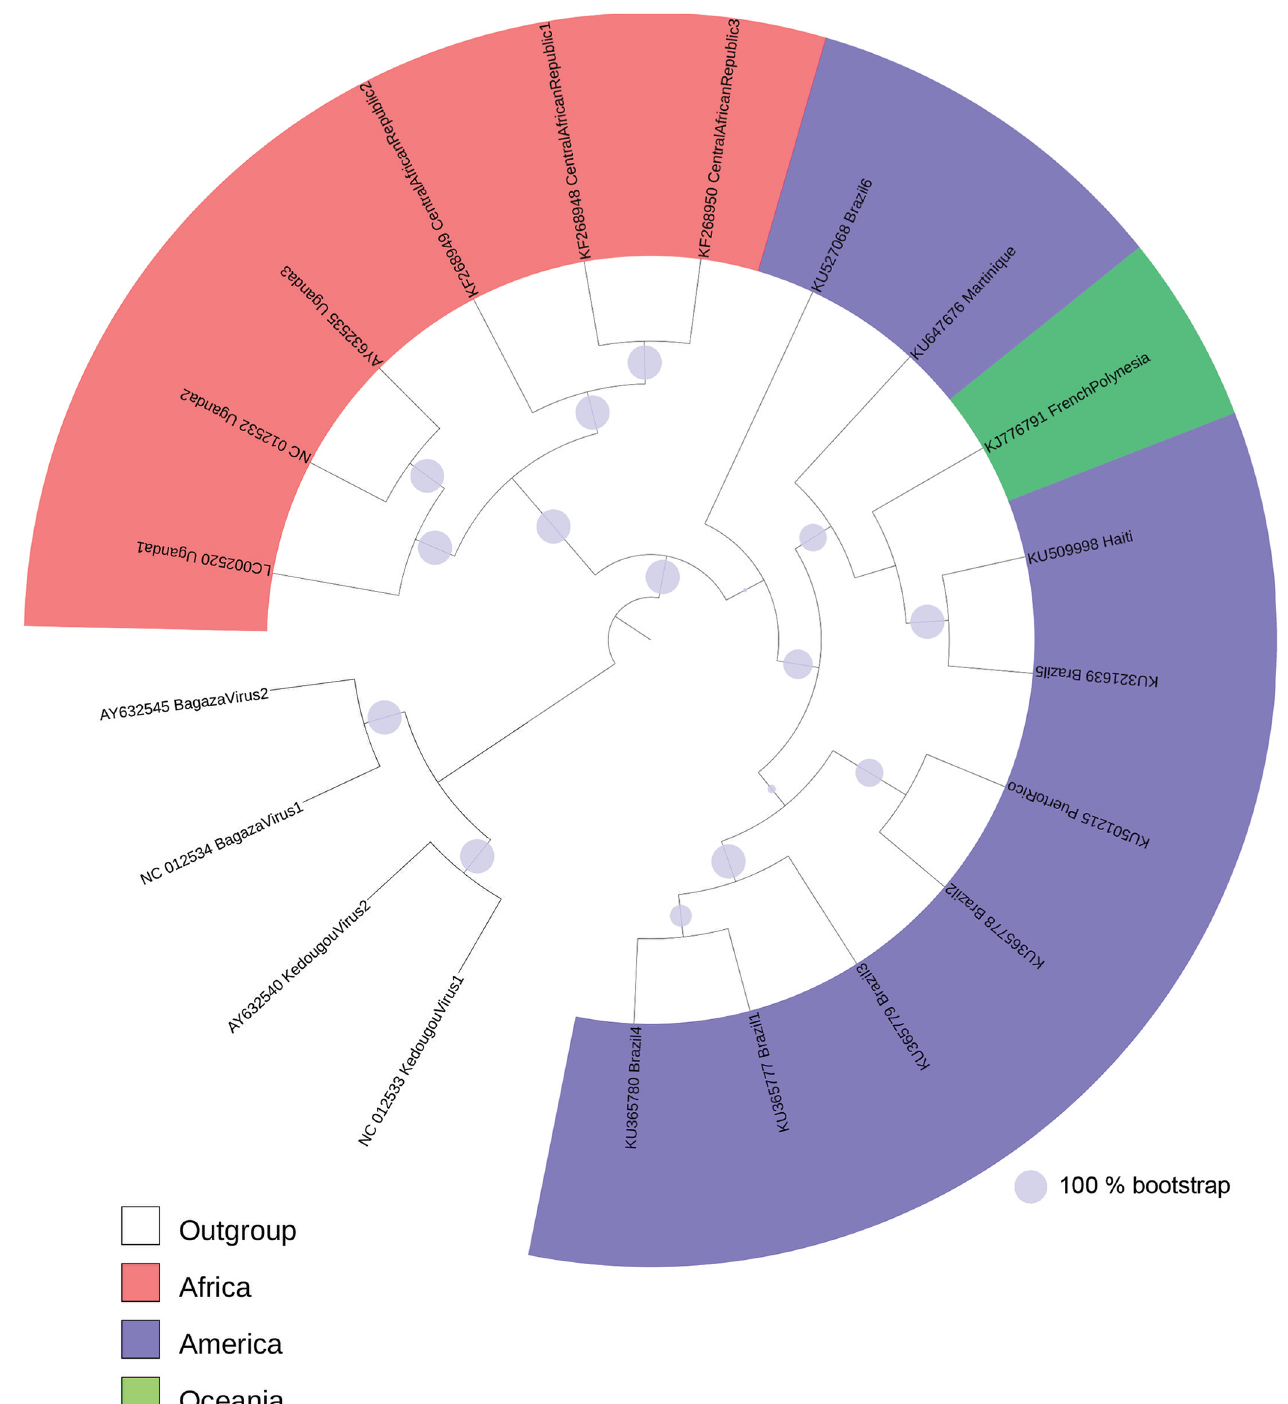
Fig 1. Phylogenetic analysis of all complete genomes of Zika Virus, available at GenBank (February, 2016). The GenBank accession number and the country of origin are indicated on the ZIKV branches for all strains, except for those from de out-group, where the name of the viruses is provided [Kedougou virus (NC_012533 and AY632540); Bagaza virus (AY632545 and NC_012534)]. The size of the full circles on the branches means percentage of bootstrap (100 replicates).